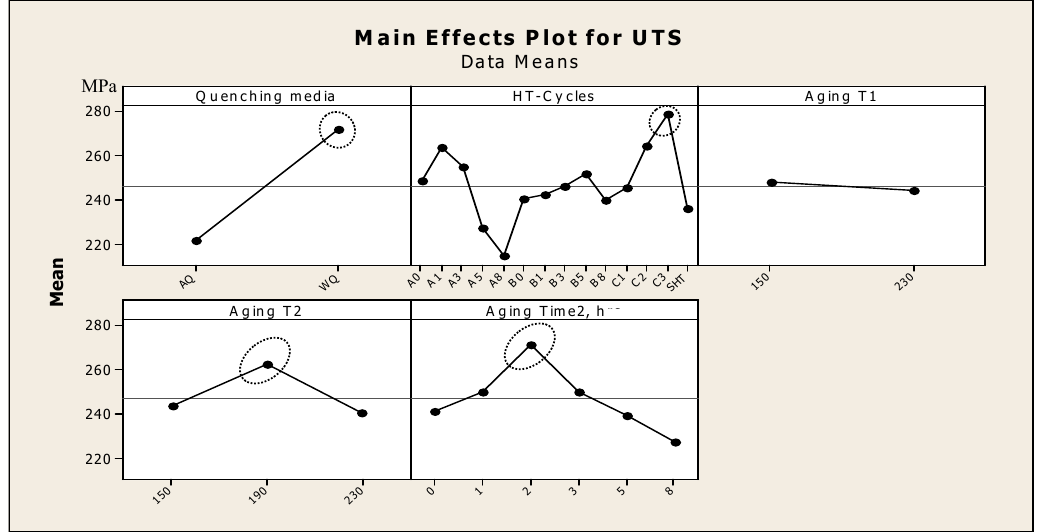
Figure 5. Main effects plot, using design of experiments (DOE), for the strength (UTS) (MPa) values of A357-SSM heat-treated using multiple thermal aging treatments.